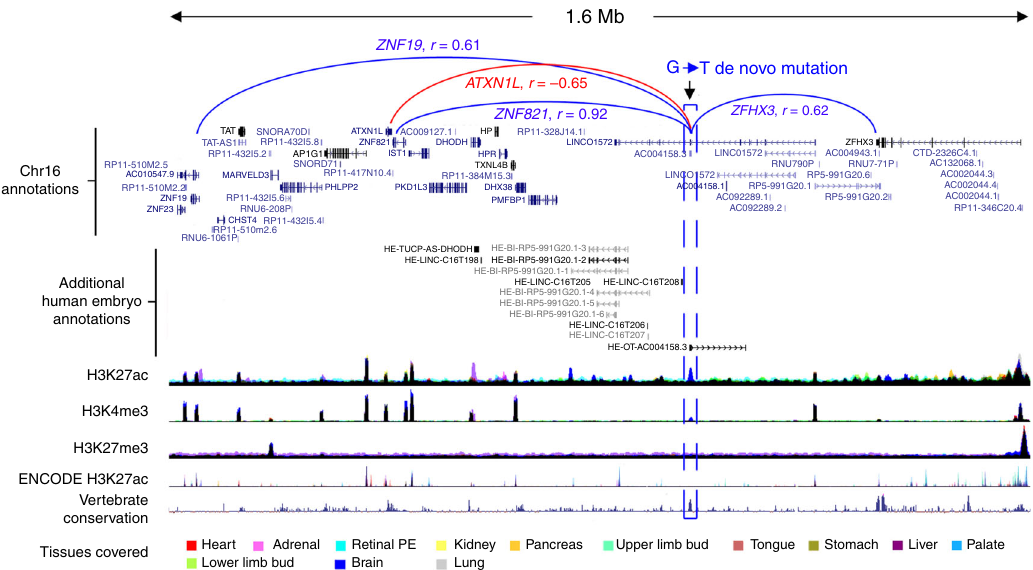
Fig. 7 Neurodevelopmental de novo mutation within brain-speci fi c histone modi fi cation correlated to surrounding gene expression. An intergenic G-to- T de novo mutation (DNM; hg38, chr16:72427838) is shown for a patient with a neurodevelopmental phenotype. Tracks are shown demonstrating additional human embryonic non-coding transcription (enriched in human embryonic brain), the three epigenomic marks, ENCODE data 26 and conservation amongst vertebrates. The DNM overlaps a brain-speci fi c (dark blue) H3K27ac and small H3K4me3 mark. The highest correlations are shown, notably to the promotors of ZNF821 ( r = 0.92) (dark blue) with anticorrelation ( r = − 0.65, red) to the adjacent gene, ATXN1L